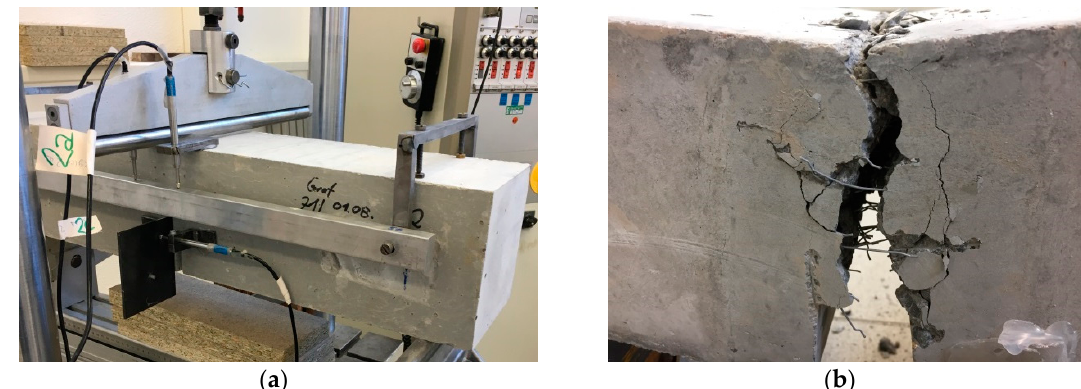
Figure 8. ( a ) Test setup used and ( b ) close up view of the typical fracture region (failure mode) observed in the flexural tests on notched beams.